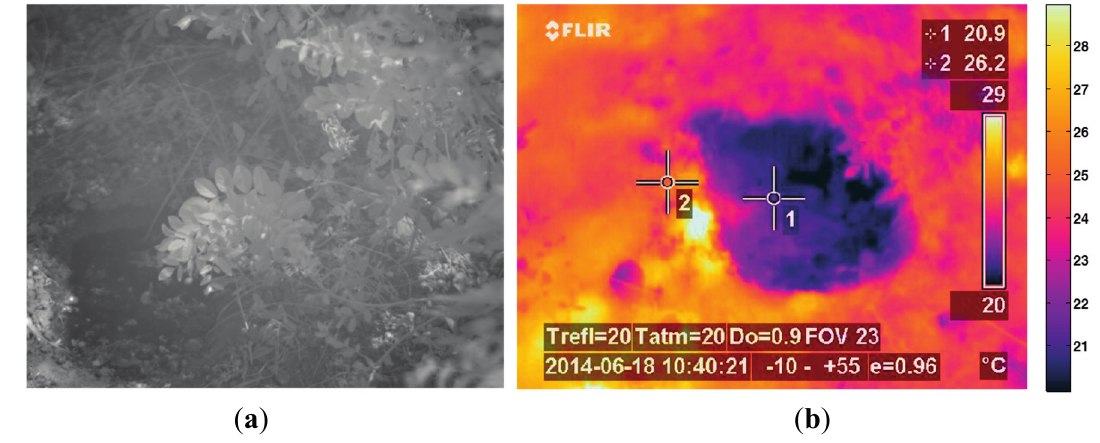
Figure 11. ( a ) Normalised SWIR image; ( b ) LWIR thermal image.